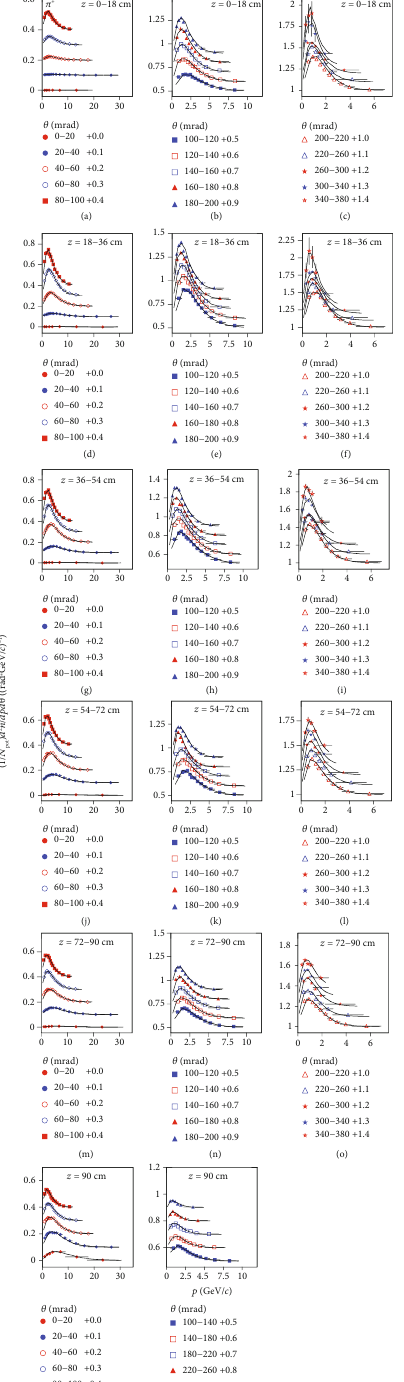
Figure 1: Momentum spectra of π + produced in p -C collisions at 31GeV/ c . Panels (a – c), (d – f), (g – i), (j – l), (m – o), and (p – q) represent the spectra for z = 0 – 18, 18 – 36, 36 – 54, 54 – 72, 72 – 90, and 90 cm, respectively. The symbols represent the experimental data [32]. The curves are our results fi tted by the multisource thermal model due to Equation (1) and the Monte Carlo method. To show clearly, di ff erent spectra are scaled by adding di ff erent amounts marked in the panels.